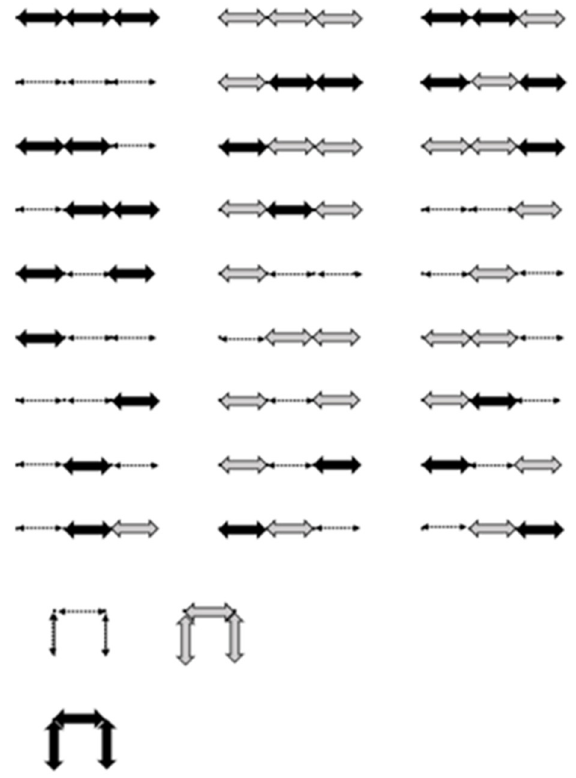
Figure 10. All 30 lattice walks of entry R 3 ( 3, 0 ) of ( R ∗ ) 3 . Variation of arrows represent j = 3 different colored E steps.